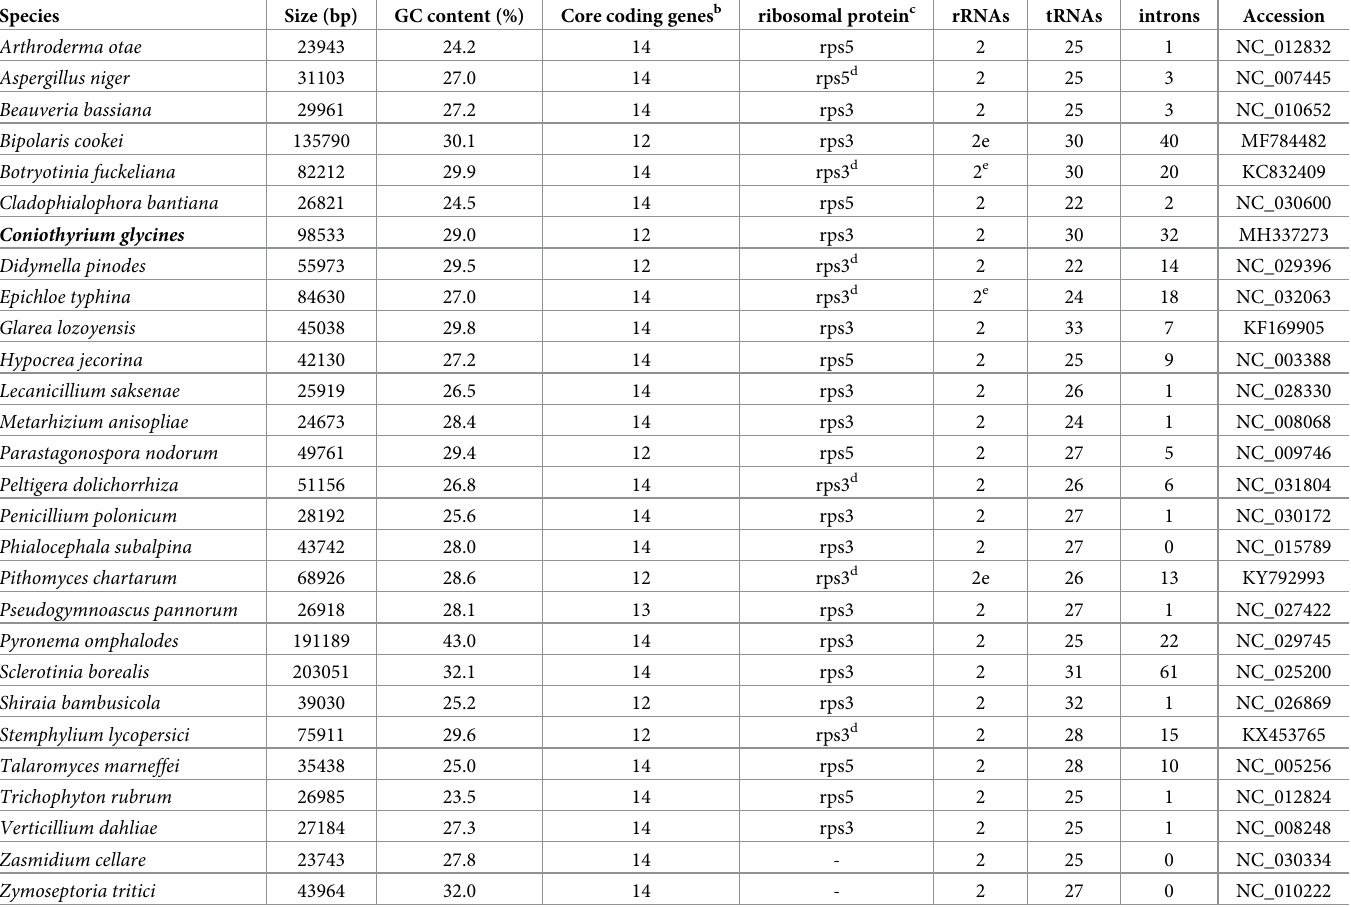
Table 4. A comparison of the general features of some completely sequenced fungal mitochondrial genomes a